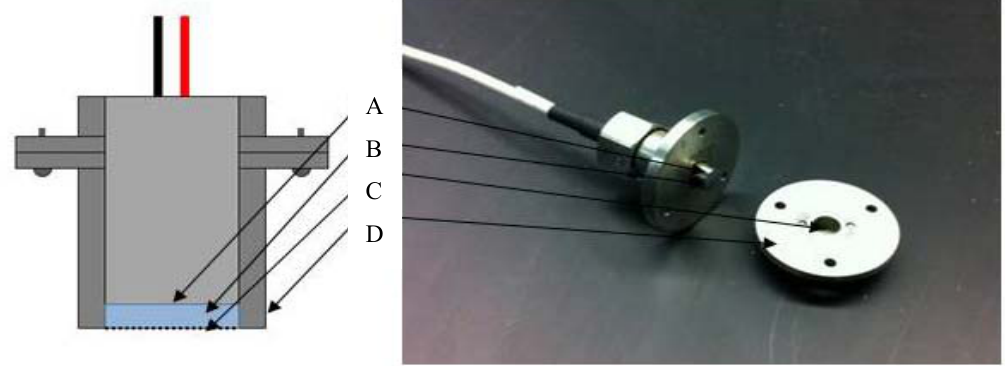
Figure 1. The set up for the Han chemomechanical sensor includes a piezoresistive surface pressure sensing surface ( A ), a hydrogel sample of 400 µm in thickness and 3.5 mm